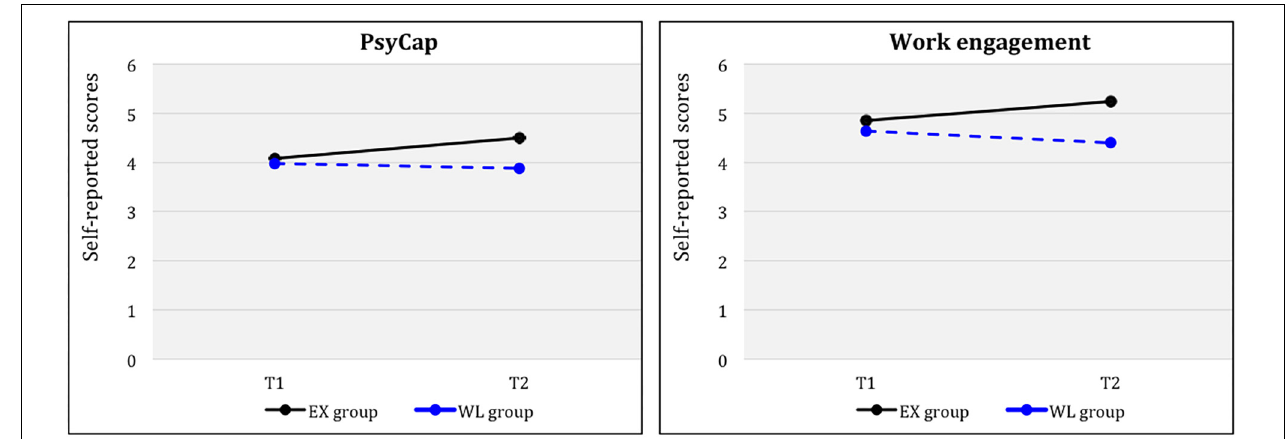
FIGURE 4 | PsyCap and work engagement for groups (EX, WL) across time (Tl,